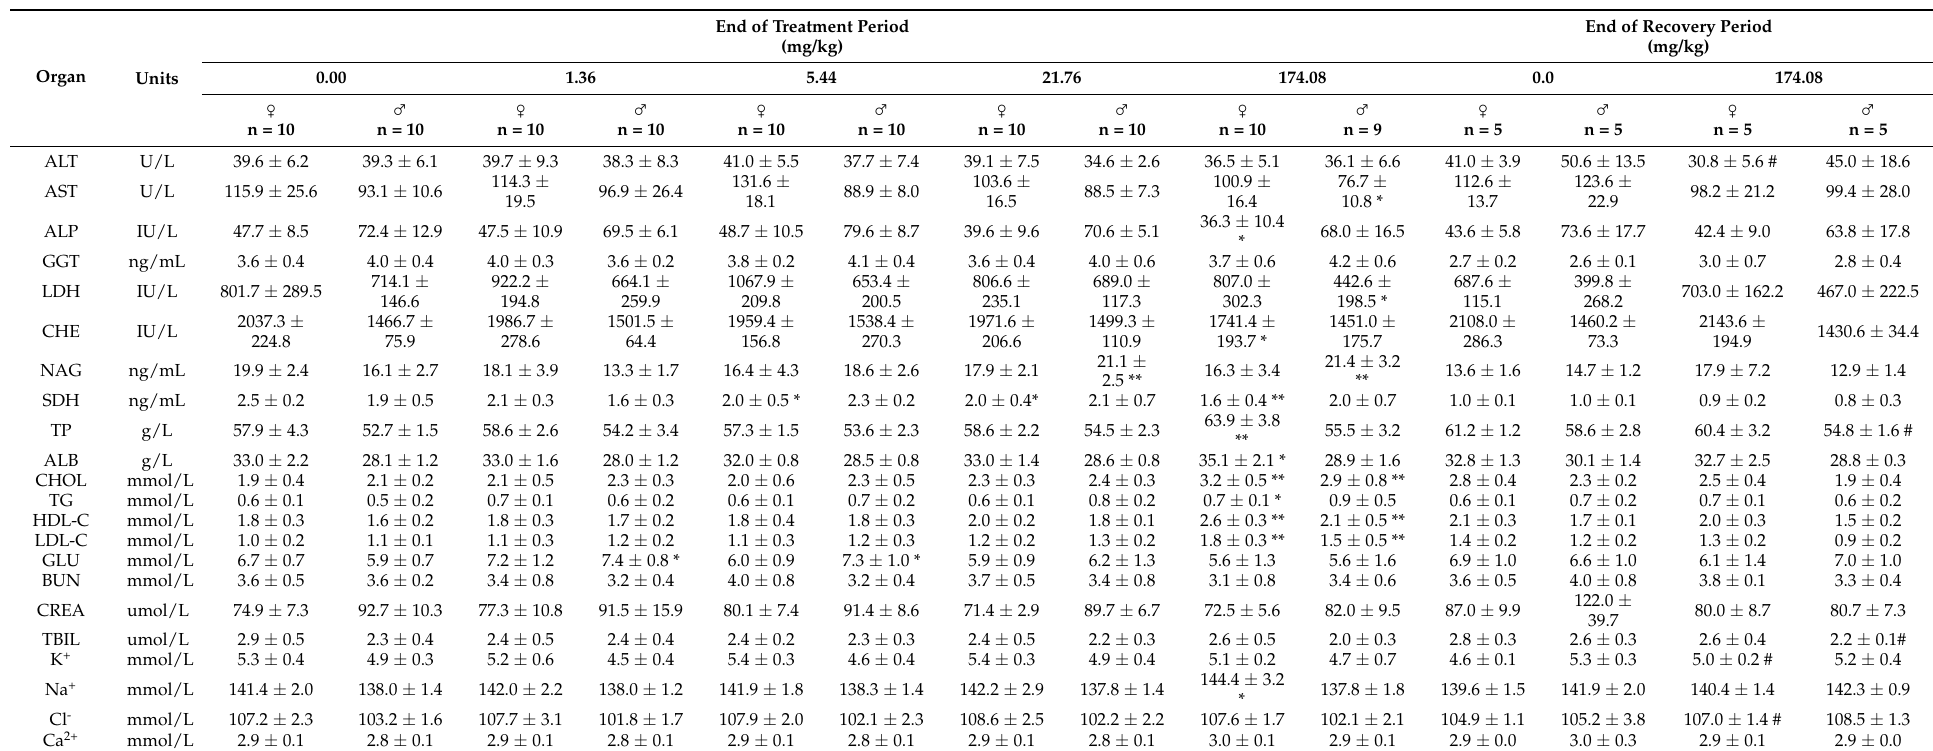
Table 2. Blood chemistry values in SD rats orally administered AQ for 90